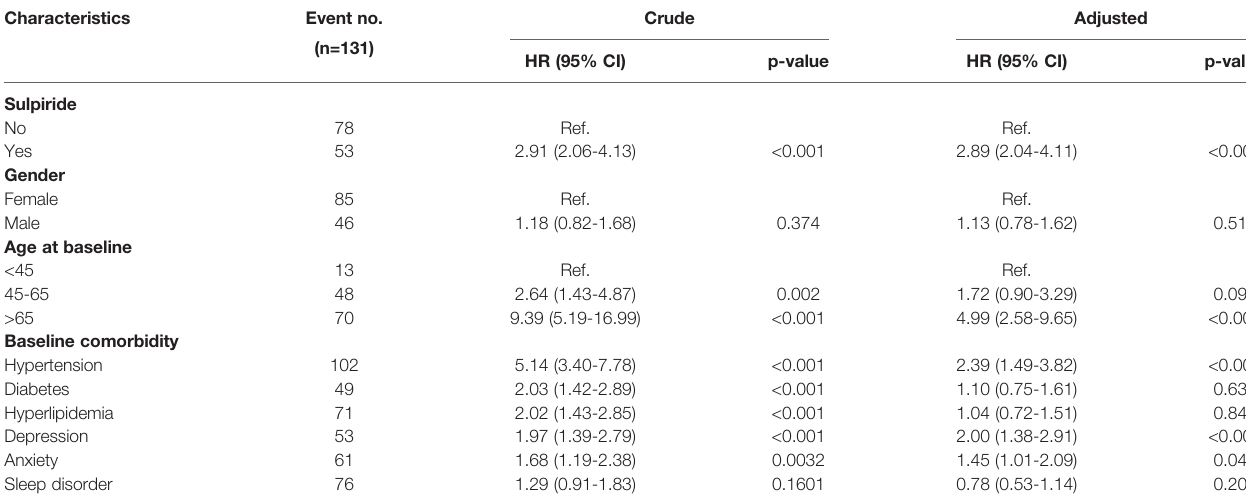
TABLE 2 | Cox model measured hazard ratio and 95% con fi dence intervals of parkinsonism associated with or without sulpiride and covariates among PUD or GERD patients. Characteristics